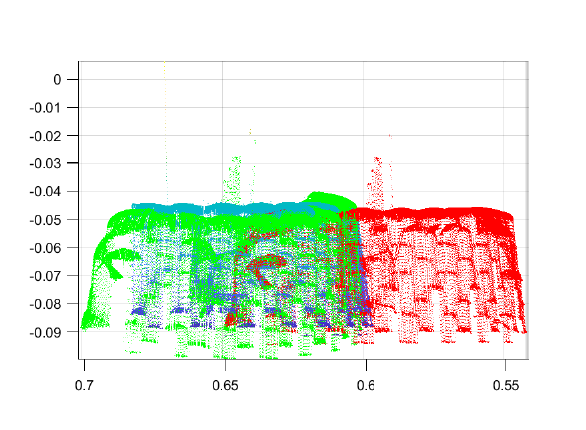
Figure 10. Initial point cloud (blue), point cloud after repositioning (red) with additional material and rebar in the back ground as well as increased radius due to drying deformations of the